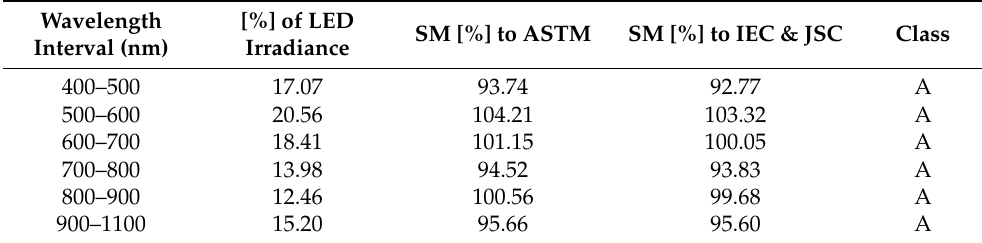
Table 3. LED LASS prototype irradiance and integrated target spectral irradiance ratios.